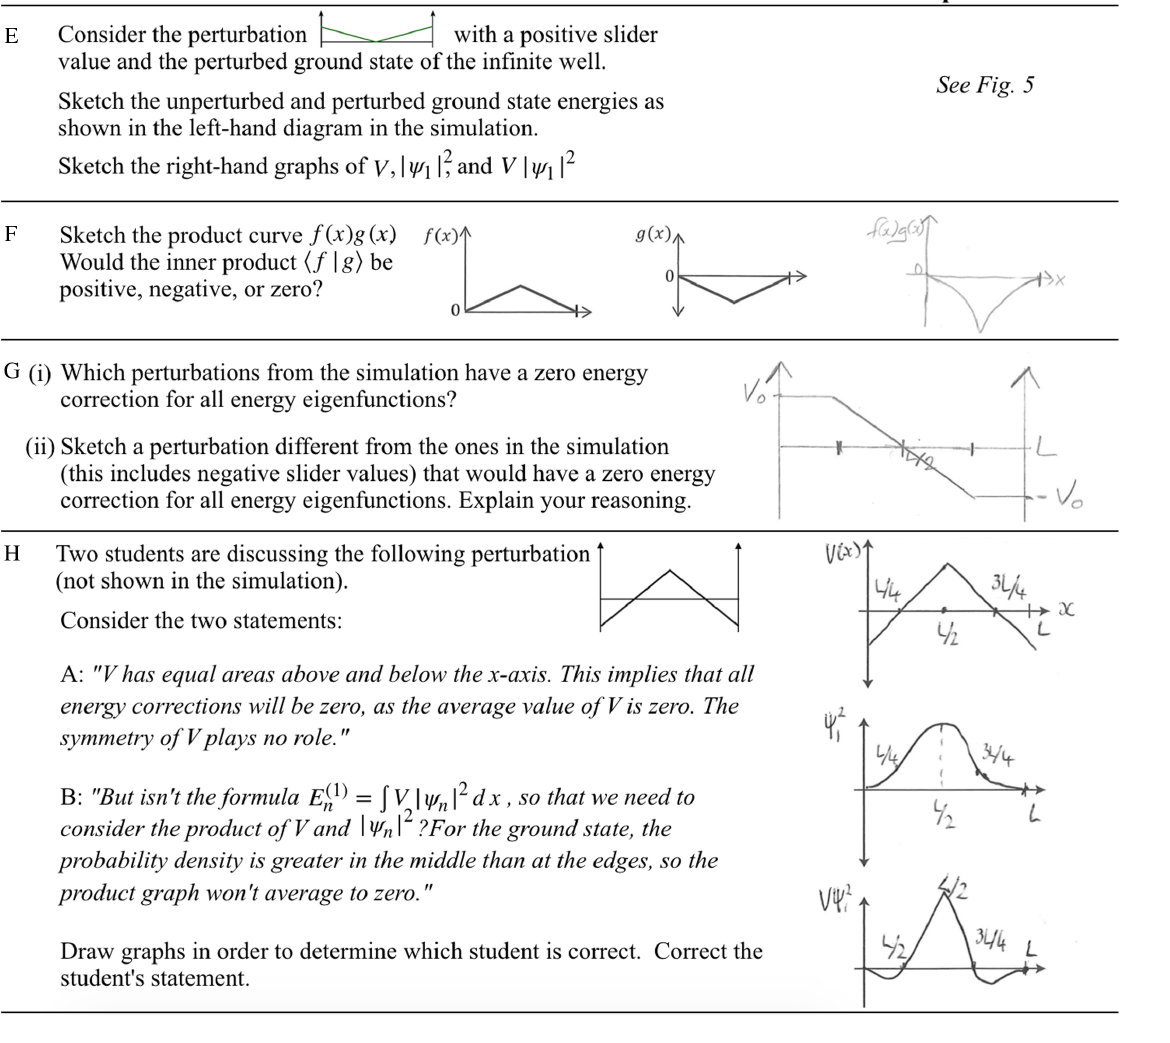
FIG. 4. Abbreviated versions of tasks E, F, G, and H of the energy corrections in a perturbed infinite well activity and sample student sketches. They are only a subset of the tasks that are asked of students while working with the simulation (see Supplemental Material [73] for the full activity). The roles of sketching in these tasks are to observe (task E), to understand the properties of a visual representation (task F), and to reason (tasks G and H). Tasks E and H provides three blank axes for students to use that scaffold the sketching of graphs of the perturbation, the probability density, and their